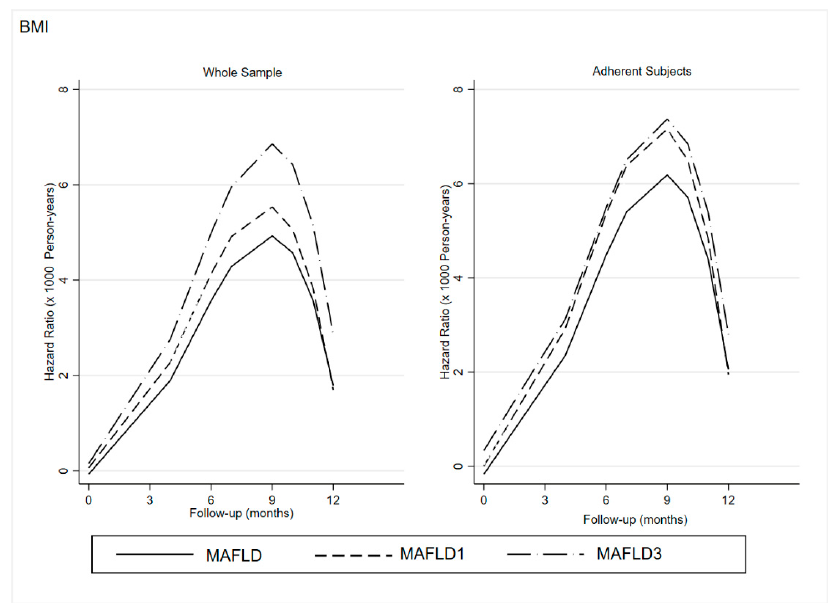
Figure 1. BMI: Effect of Adherence to LGIMD and CEP on Hazard Ratio of Time-to-Event (Loss of MAFLD Diagnostic Criteria for Whole Sample and Adherent Participants). BMI: Body Max Index; MAFLD: Metabolic-Associated Fatty Liver Disease: MAFLD1; presence of hepatic steatosis in overweight/obese subjects; MAFLD3: presence of hepatic steatosis and type 2 diabetes mellitus.